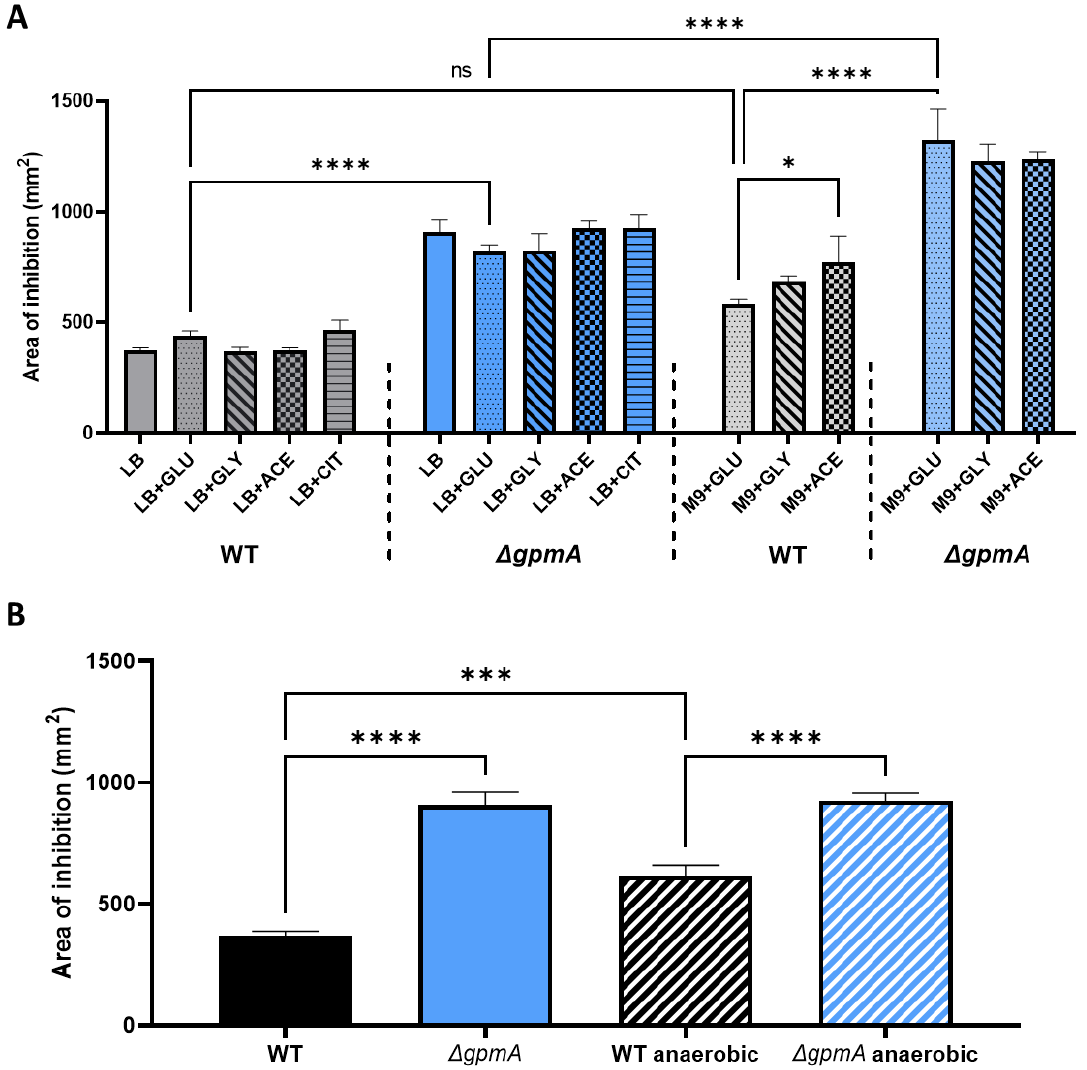
Figure 6. The difference in H 2 O 2 tolerance between WT and Δ gpmA mutant is not affected by the addition of other carbon sources or the absence of oxygen. ( A ) Area of inhibition assessed by disk diffusion assay of WT and Δ gpmA strain on LB and M9 minimal medium complemented with di- verse carbon source. GLU: glucose, GLY: glycerol, ACE: acetate, CIT: citrate (mean +/− SD, N = 3). ( B ) Area of inhibition of the WT and Δ gpmA strain under aerobic and anaerobic conditions (mean +/− SD, N = 3). Data in ( A ) and ( B ) were analyzed by one-way ANOVA with Tukey test for multiple comparison, and *, ***, **** correspond to p < 0.05, 0.001, 0.0001 respectively.